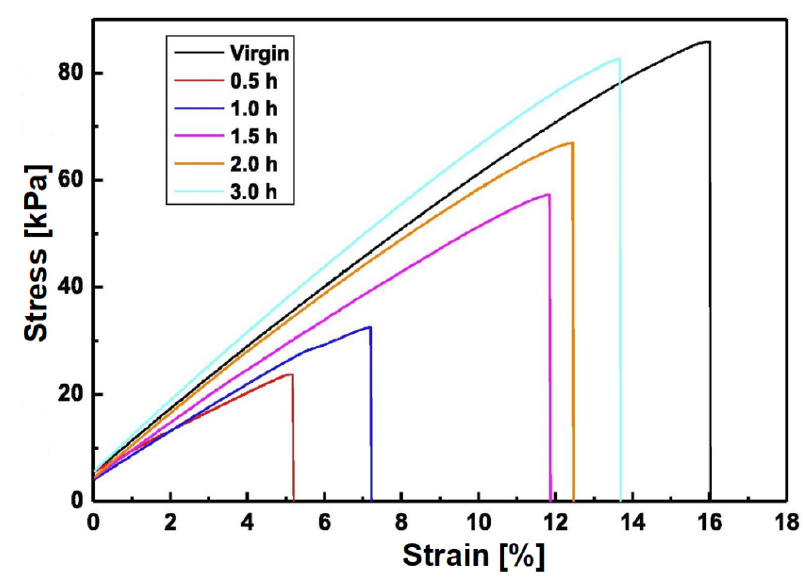
Figure 12. Schematics of the stress–strain curves of specimens under different bonding times [42]. It can be concluded that the relationship between interface stress and the bonding time calculated in this research shows good agreement with the experimental results in [42], as shown in Figure 13. The used parameters can be found in Table 1. The chain dynamics parameters and Rouse friction coefficients were within the reasonable order compared with the results in [38,45].